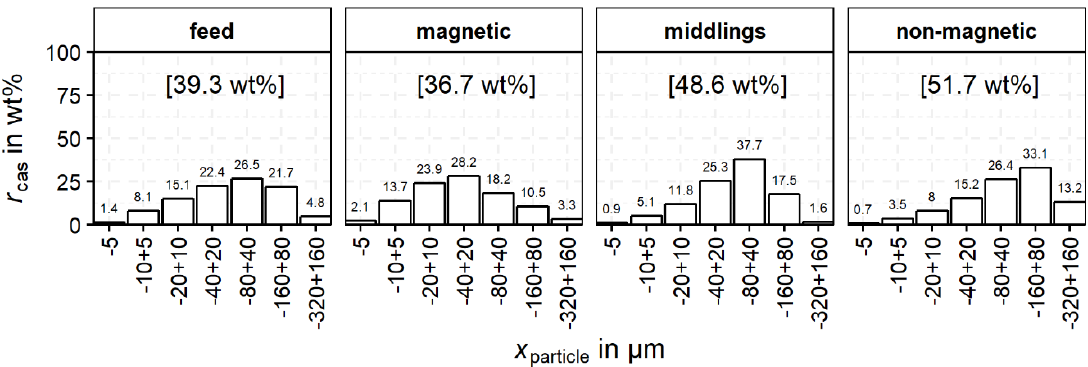
Figure 15. Distribution of cassiterite ( r cas ) in 100% liberated class as function of x particle size for the different products (values in brackets indicate proportion of 100% liberated cassiterite of total cassiterite in feed and each product).